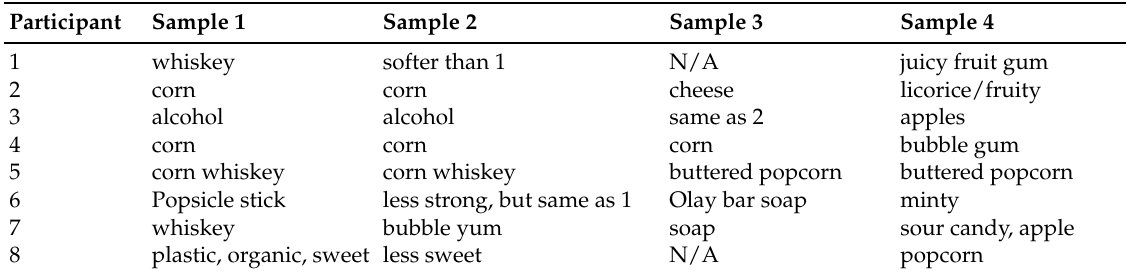
Table 3. Sample notes from individual sensory evaluations.